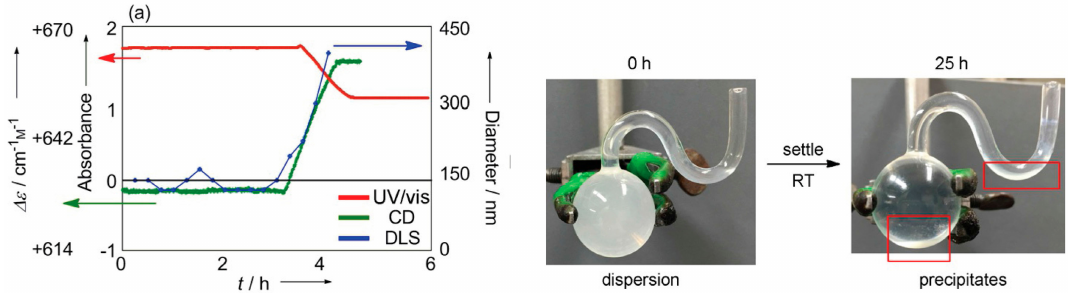
Figure 38. Absorbance/time profiles obtained by UV-vis and CD analyses of mixture of ethynylhelicene ( P )-pentamer and ( P )-nanoparticles in trifluoromethylbenzene. Diameter/time profiles (blue line) obtained by DLS analysis. Pictures of the precipitation experiment are also shown. Reproduced from reference 114 by permission from John Wiley &